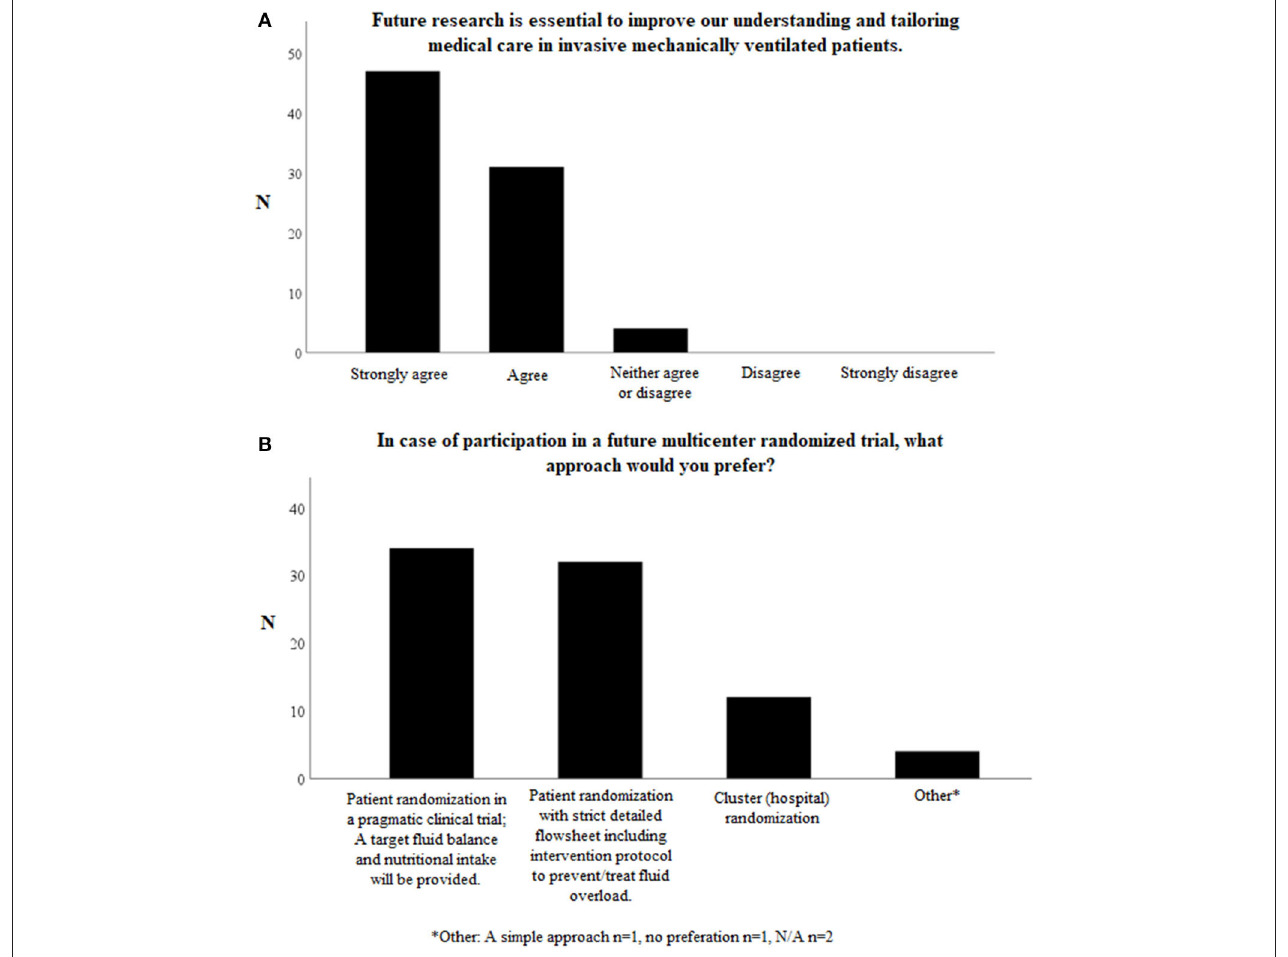
FIGURE 4 | Questions on possible future studies on fluid management in invasively mechanically children. Total number of respondents N = 82. (A) Further research in fluid management is essential to improve our understanding and tailoring medical care in invasive mechanically ventilated patients. (B) In case of participation in